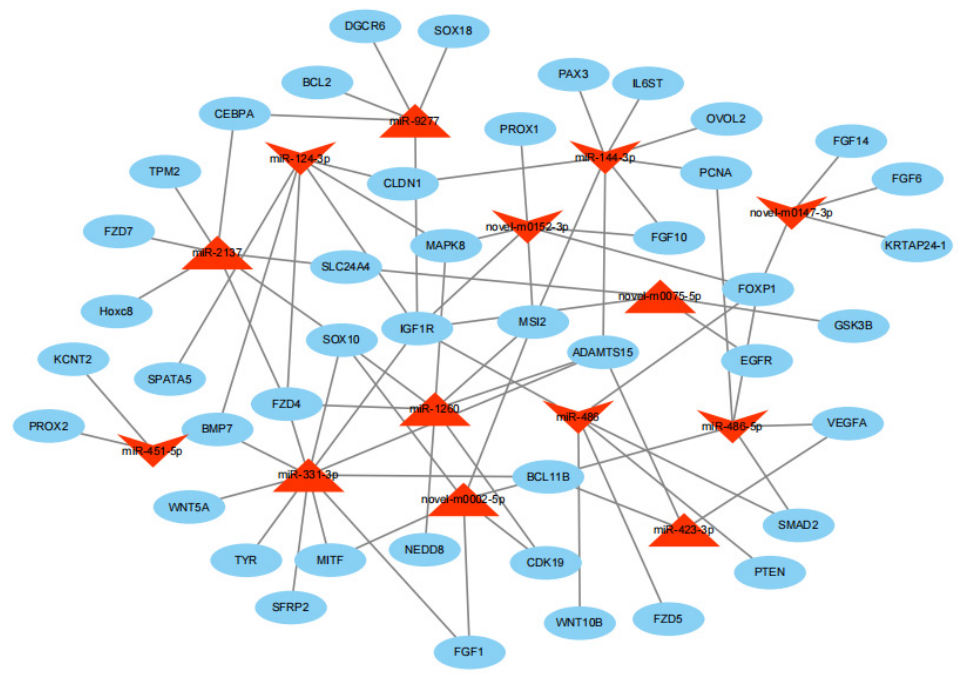
Figure 6. The miRNA-mRNA interaction figure. The red triangles and inverted triangles indicate up-regulated and down-regulated miRNAs in the skin tissue samples of LC goats when compared to ZB goats, respectively. Blue circles represent the target genes.